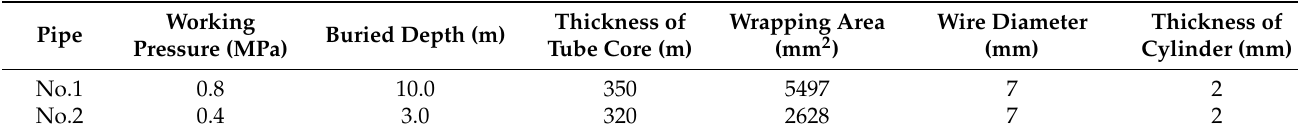
Table 1. The design parameters of pipes.